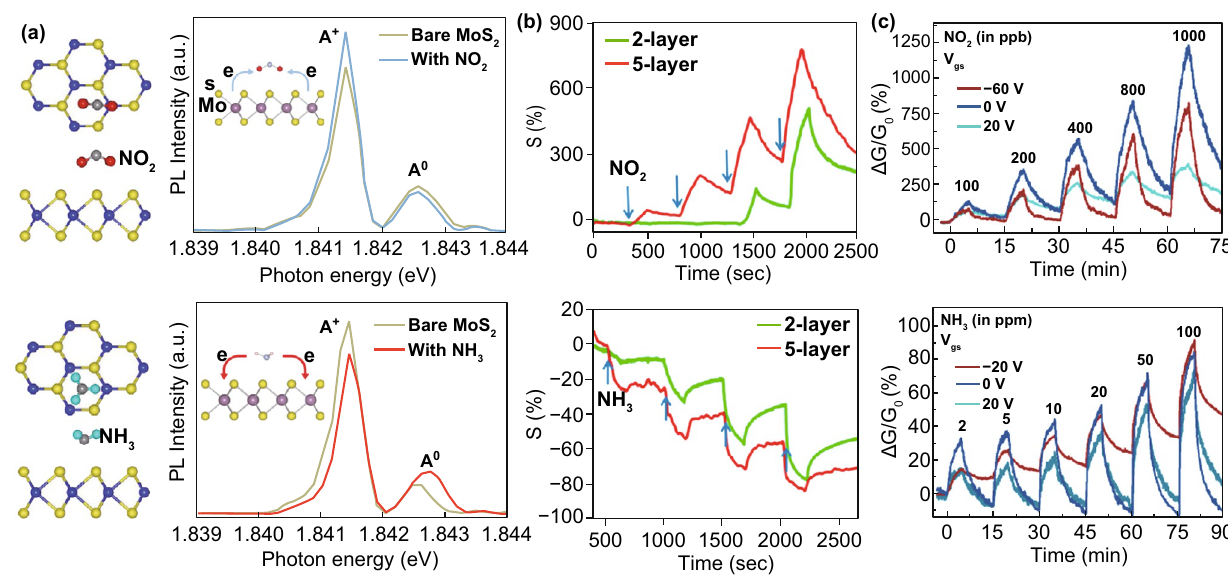
Fig. 3 2D TMDC FET sensors for oxidizing and reducing gas detection. a Top and side views of favored configurations of NO 2 and NH 3 adsorbed on MoS 2 and in situ PL spectra of MoS 2 with NO 2 and NH 3 . The insets present the difference in electron transfer process between gases and channel: NO 2 and NH 3 on the surface of MoS 2 act as electron acceptor and donor, respectively. Reprinted with permission from Ref. [16], Copyright 2015, Springer Nature. b Dynamic sensing responses of MoS 2 FET to NO 2 and NH 3 with different layer numbers of MoS 2 . Reprinted with permission from Ref. [89], Copyright 2013, American Chemical Society. c Real-time response (relative conductance change) of p-type MoTe 2 FET sensor to NO 2 and n-type MoTe 2 FET sensor to NH3 under different gate biases. Reprinted with permission from Ref. [42], Copyright 2017,